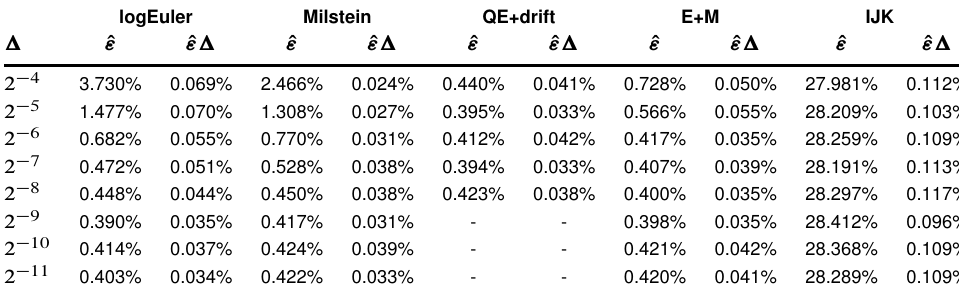
Table 5. Results for (cid:129) D 2 (cid:0) 4 (cid:0) 2 (cid:0) 11 , for 100 000 simulated paths, number of batches M D 100 . IJK scheme is included. logEuler